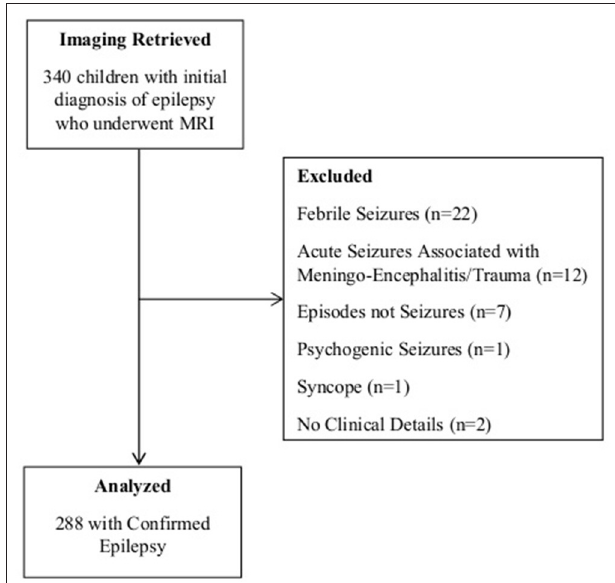
FIGURE 1 | Study flowchart.